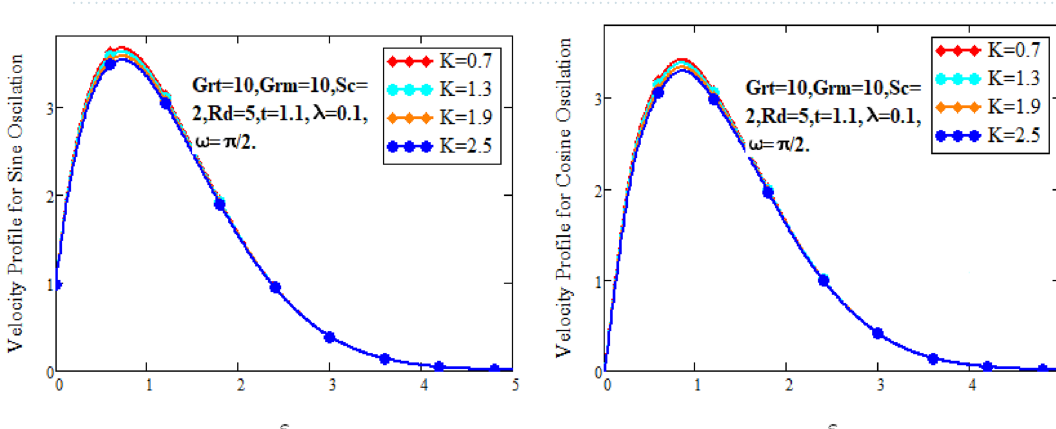
Figure 6. Velocity curves for various values of Sc .